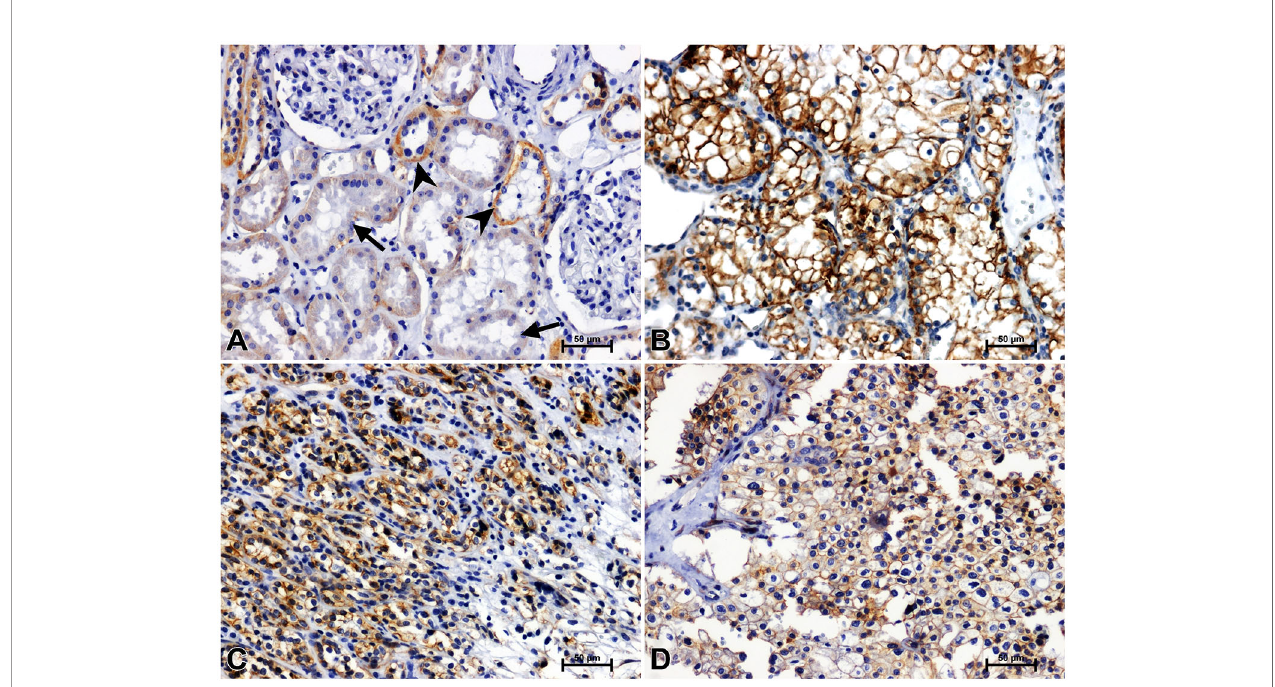
FIGURE 3 | Positive b -catenin immunostaining in distal (arrowheads) and proximal (arrows) tubules of non-malignant kidney (A) . Results of b -catenin immunostainig in clear cell RCC (B) , papillary RCC (C) , chromophobe RCC (D) .